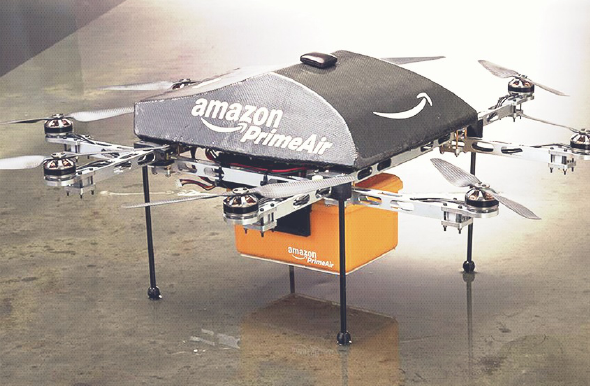
Figure 1: Example of multirotor UAV design by Ama- zon for transport and delivery of